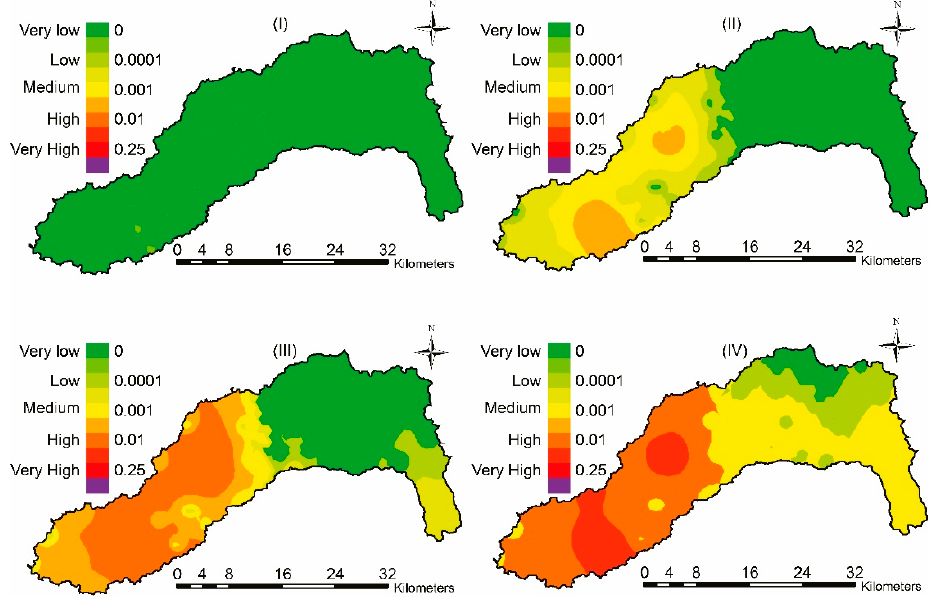
Figure 4. Leaching potential of Monocrotophos in Jazan watershed as assessed by expanded attenuation factor (EAF) index model under four leaching potential scenarios: low, 0.0003 m d − 1 (I); medium, 0.0005 m d − 1 (II); high, 0.001 m d − 1 (III); and very high recharge rate, 0.002 m d − 1 (IV).